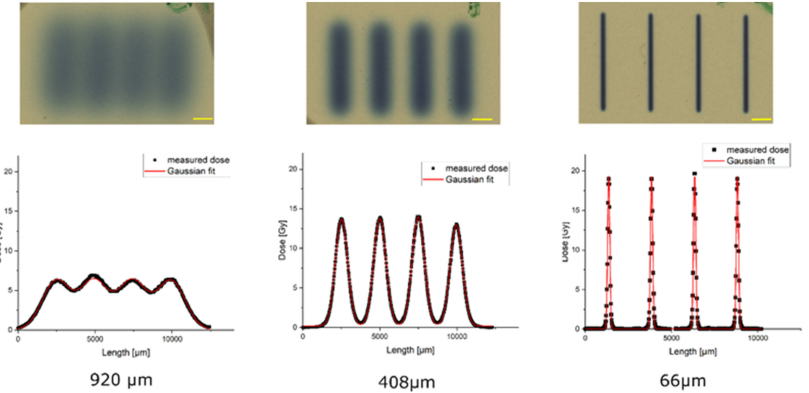
Figure 1. Dose distributions of the three planar minibeam irradiation modes, measured with